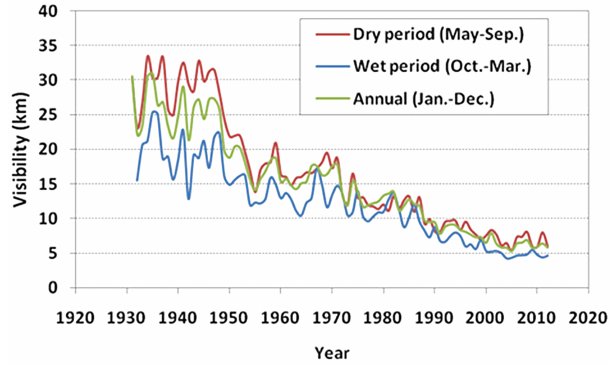
Figure 7. Long-term variability and linear trends of the an- nual precipitation amount and precipitation frequency (number of daysyear − 1 with precipitation > 1mm) at NOA, over the period 1931–2013. Slopes of linear trends are also shown.